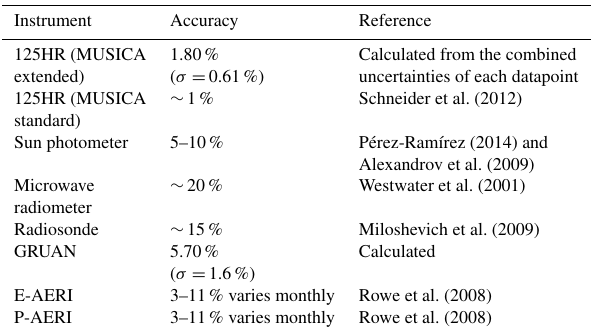
Table 2. Estimated accuracies of water vapour column retrievals for Eureka